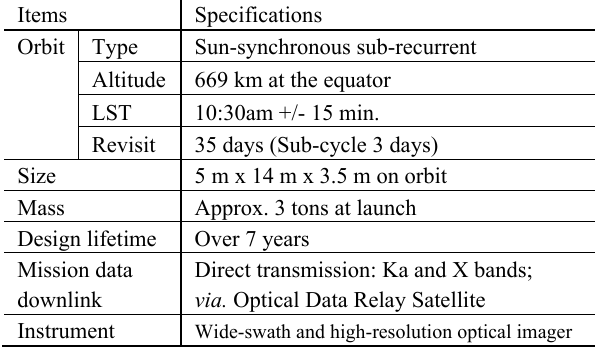
Table 1. Specification of ALOS-3